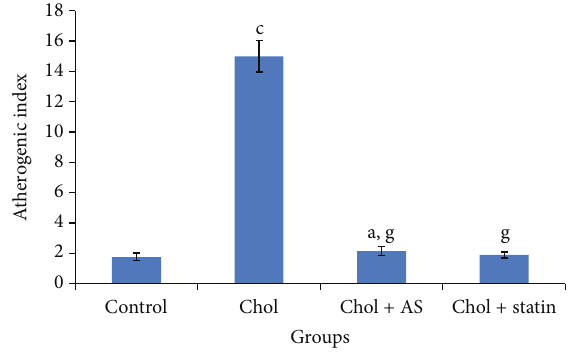
Table 1: Effects of Acacia senegal seed extract (AS, 500 mg/kg/day, p.o.) or statin (0.25 mg/kg/day, p.o.) treatment for 45 days on the alteration in plasma concentration of total cholesterol (TC), triglyceride (TG), high-density lipoprotein cholesterol (HDL-C), low-density lipoprotein cholesterol (LDL-C), and very low-density lipoprotein cholesterol (VLDL-C), all in mg/dL and on TC/HDL-C ratio and on atherogenic index in hypercholesterolemic (Chol) diet fed atherosclerotic male rabbits. Groups TC TG HDL-C LDL-C VLDL CHO/HDL Control 89.48 ± 6.25 101.40 ± 8.23 Chol 523.59 ± 33.66 c Chol + AS 92.50 ± 6.43 d,g Data are means ± S.E.M. ( 𝑛 = 8); a 𝑃 ≤ 0.05; b 𝑃 ≤ 0.01; c 𝑃 ≤ 0.001; and d nonsignificant as compared to the respective control values. g 𝑃 ≤ 0.001 and h nonsignificant as compared to the respective values of the Chol diet fed group. Table 2: Effects of Acacia senegal seed extract (AS, 500 mg/kg/day, p.o.) or statin (0.25 mg/kg/day, p.o.) treatment for 45 days on the alteration in total wall area (TWA), lumen, intima, media, adventitia, and plaque, all in mm (images of Camera Lucida at 4 × 8 magnification; all in % of total area) in hypercholesterolemic (Chol) diet fed atherosclerotic male rabbits. Groups TWA Lumen Intima Plaque Media Adventitia Control 48.42 ± 1.99 49.74 ± 1.44 Chol 67.16 ± 4.61 a Chol + AS Chol + statin 49.69 ± 1.02 d,e 48.93 ± 2.44 d,e 10.39 ± 0.34 d,e Data are means ± S.E.M. ( 𝑛 = 8); a 𝑃 ≤ 0.05; b 𝑃 ≤ 0.01; c 𝑃 ≤ 0.001; and d nonsignificant as compared to the respective control values. e 𝑃 ≤ 0.05; g 𝑃 ≤ 0.001; and h nonsignificant as compared to the respective values of the Chol diet fed group.